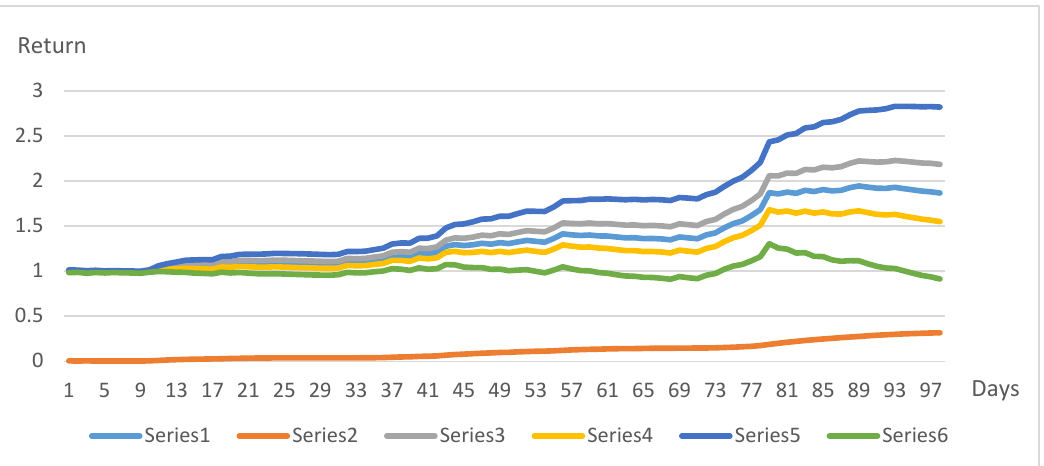
Figure 13. Confidence intervals of return on 3 stocks’ portfolio (UK market) (source: compiled by the authors based on Yahoo Finance data and own calculations).